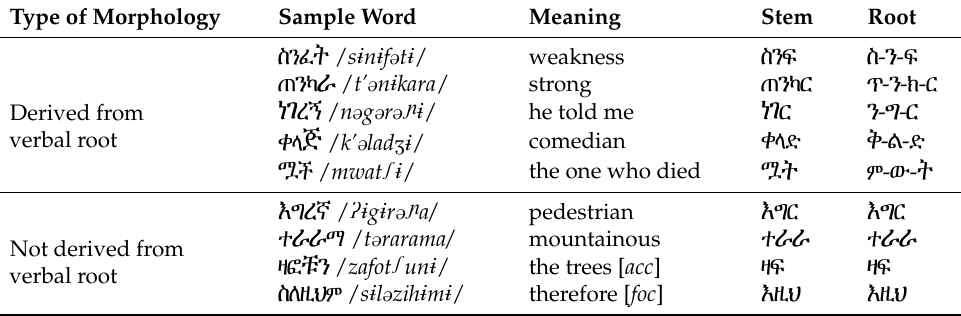
Table 7. Examples of stem and root representation. Table 1. Stem and word formation.